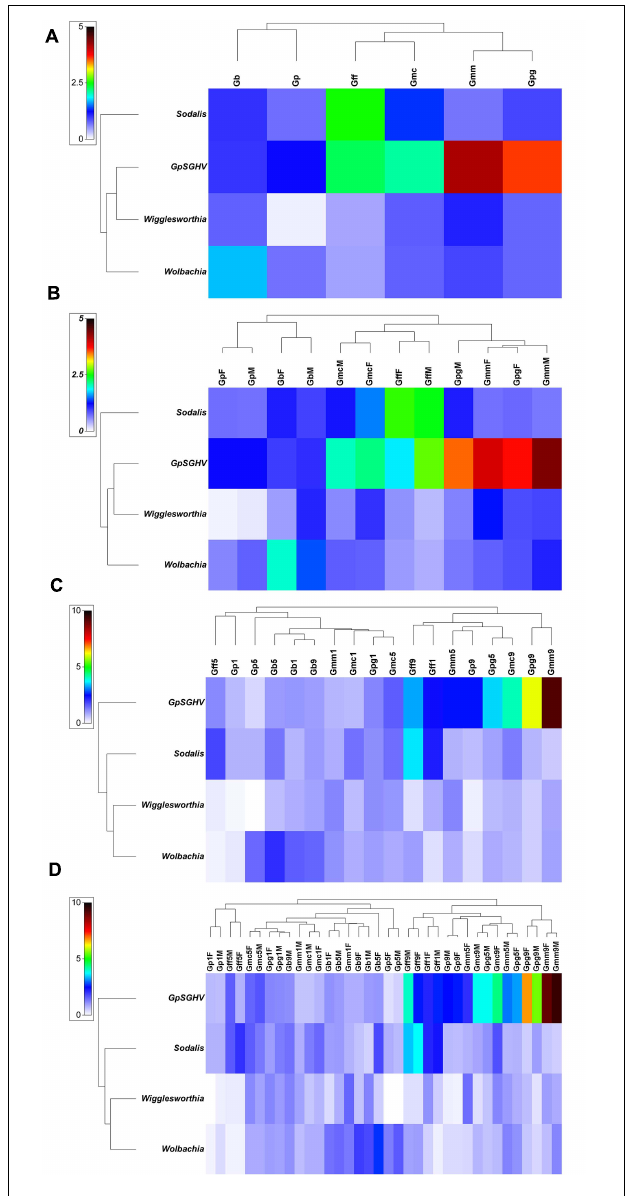
FIGURE 3 | Relative density of GpSGHV, Wigglesworthia , Sodalis and Wolbachia in six taxa of tsetse flies. Tsetse adults were injected with GpSGHV and the density of GpSGHV and tsetse symbionts were analyzed by qPCR and the data were normalized against control flies and zero time of injection. Data were transformed to square root and averaged based on tsetse species (A) , tsetse species and sex (B) , tsetse species and time post GpSGHV injection (C) , and tsetse species, time post GpSGHV injection and sex (D) . Gb, Glossina brevipalpis ; Gff, G. f. fuscipes ; Gmc, G. m. centralis ; Gmm, G. m. morsitans ; Gp, G. pallidipes ; Gpg, G. p. gambiensis . Time post GpSGHV injection: 1, 5, and 9 dpi. F: female, M: